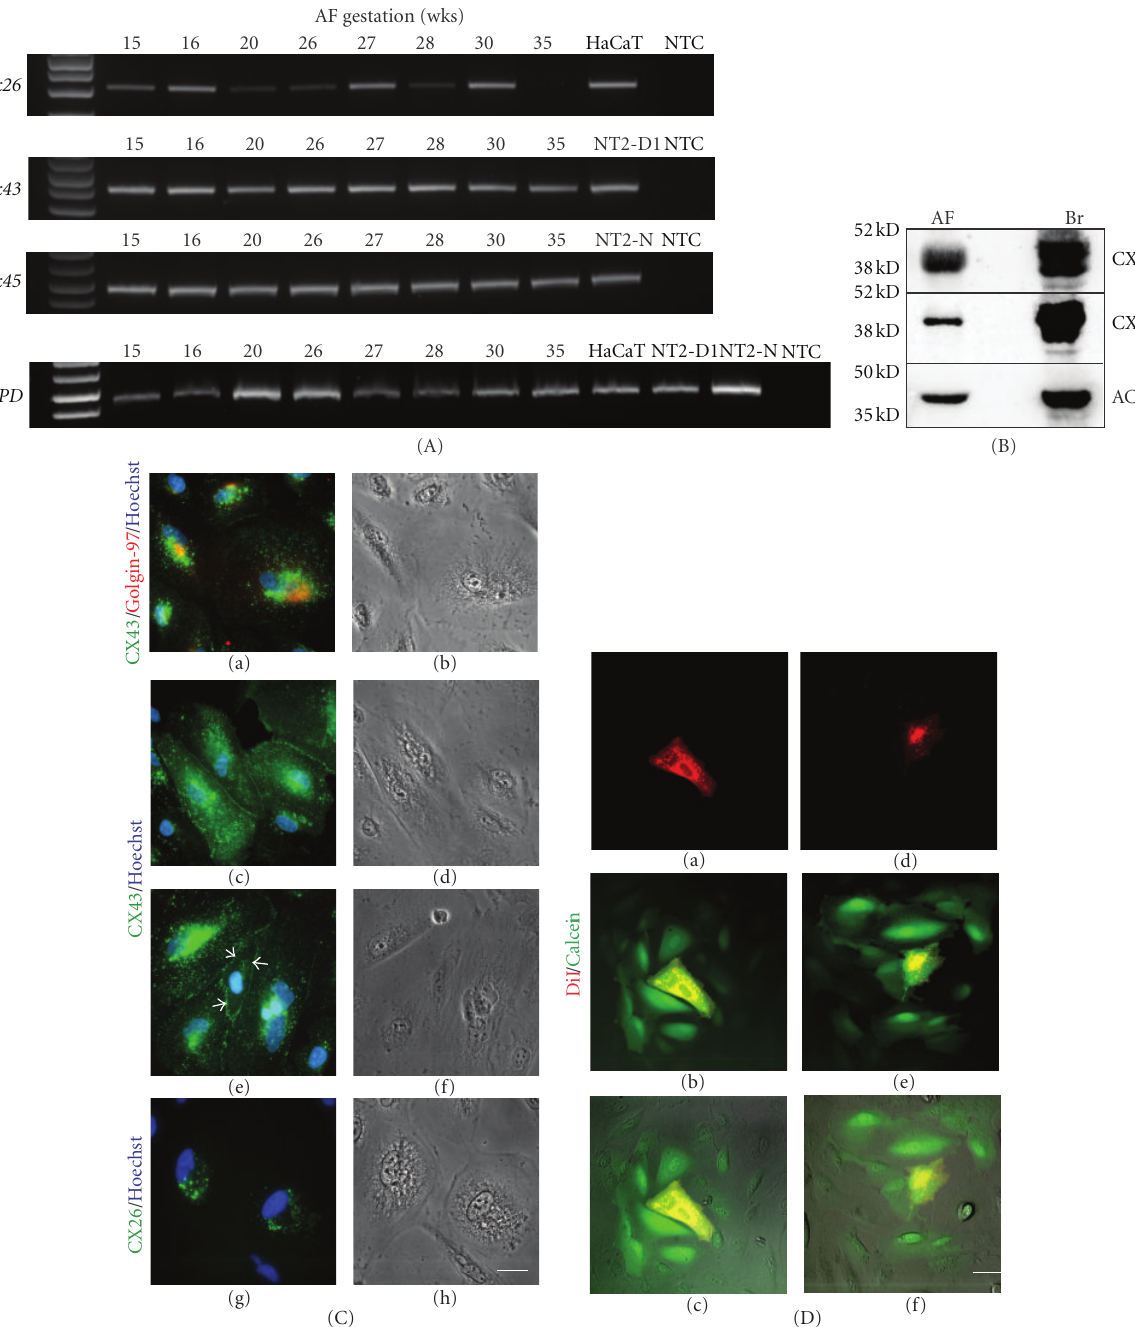
Figure 1: Expression of connexins in human amniotic fluid (AF) cells. Figure 1(A): RT-PCR analysis of Connexin ( CX ) expression in AF cells at 15 to 35 weeks (wks) gestation. AF cells expressed CX26 , CX43 , CX45 in all gestation periods examined. GAPDH transcript and human HaCaT, NT2-D1, and NT2-N cells were used as internal and positive controls, respectively. NTC, No Template Control. HaCaT, Human keratinocyte cell line; NT2-D1, (NTera-2) human teratocarcinoma cell line and NT2-derived neurons (NT2-N). Figure 1(B): Western blot analyses confirmed the expression of CX43 protein in AF26 (top panel) and AF30 (middle panel) cells. Embryonic day 18 (E18) mouse brain (Br) and B-ACTIN (ACTB) were used as positive and internal controls, respectively. Figure 1(C) Immunocytochemistry further verified the presence of CX43 and CX26 proteins in AF cultures. CX43 expression (green) was detected as punctate staining at the perinuclear region and the cell membrane. CX43 appeared to be associated with golgi complex in the perinuclear region, as determined by golgin-97 (red) and CX43 double staining (a). The punctate staining pattern ((a), (c), (e)) demonstrated the dynamic translocation of CX43 protein from Golgi complex (a) to the cell membrane ((e), arrowheads). Unlike CX43, CX26 protein expression appeared limited to the perinuclear region (g). Nuclei were stained with Hoechst (blue). Panels (b), (d), (f) and (h) represent the corresponding phase contrast images of (a, c, e and g); respectively. Scale bar: 25 μ m. Figure 1(D) Dye coupling assessment in AF cells. AF donor cells (AF26, (a); AF16, (d)) were preloaded with DiI (red) and calcein (green) and plated as single cell suspensions onto confluent monolayers of receiving AF cells. Calcein transferred from the donor AF cell to adjacent receiving cells, indicating the formation of functional gap junctions between individual AF cells within 4 hours. Scale bar: 50 μ